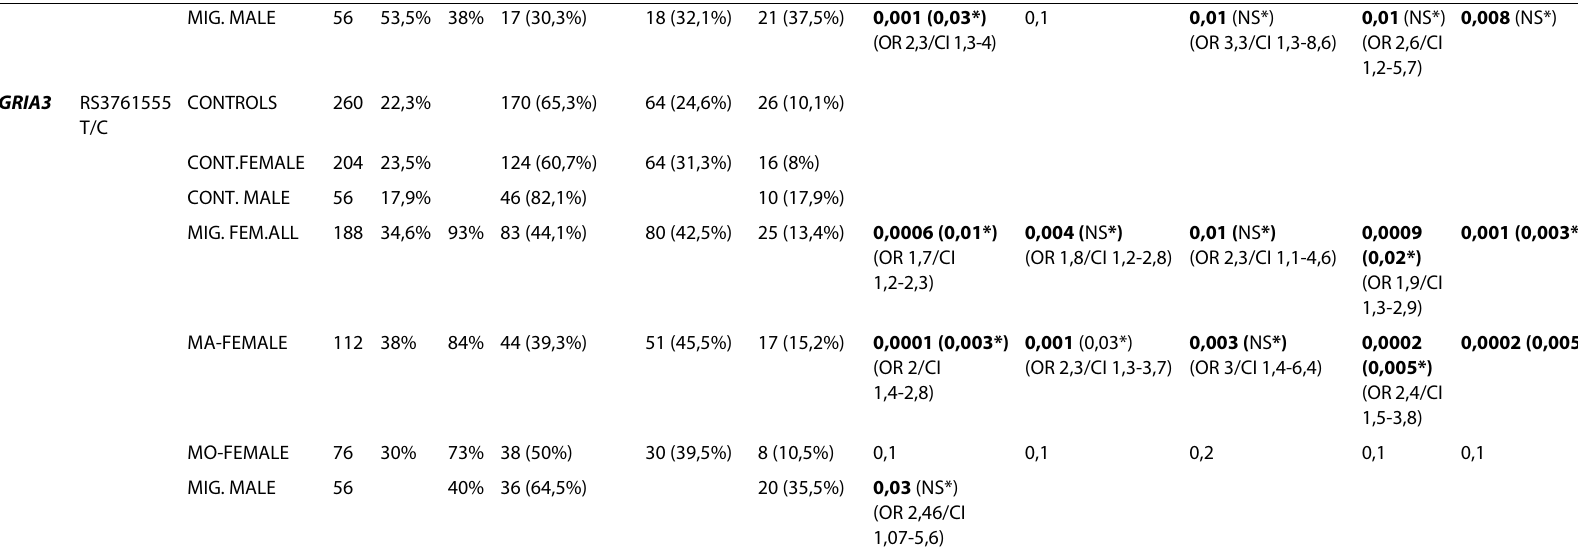
Table 2: Allele and genotype frequencies of GRIA1 and GRIA3 polymorphisms in Italian patients and controls and association results